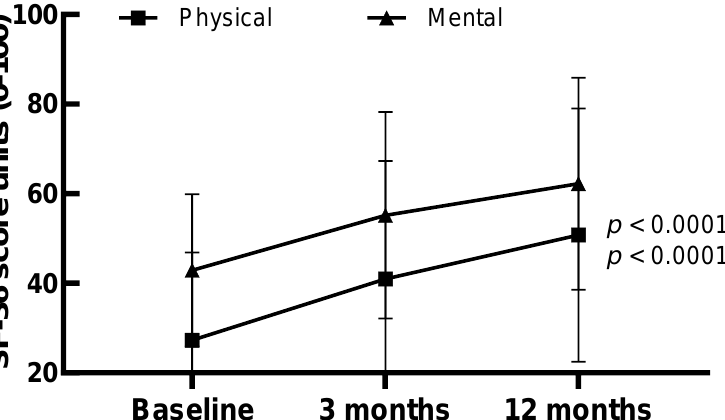
Figure 3. Spirometric values (forced expiratory volume in one second (FEV1) and forced vital ca- pacity (FVC) and the six-minute walking test (6MWT) distances at different time points following ICU discharge. Data are presented as mean (SD) values. 3.2. Family Support and SF-36 Scores Figure 4 presents details on daily support at different time points following hospital discharge. One-hundred and forty-two out of one-hundred and forty-three (99.30%) pa-